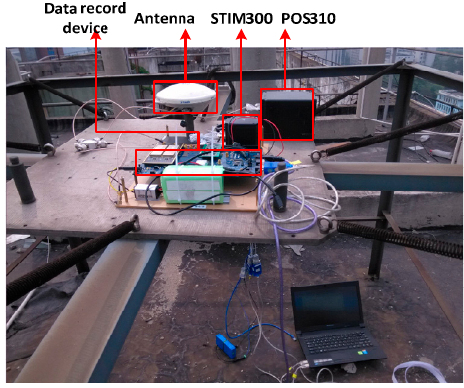
Figure 14. Tests set based on a shake table.